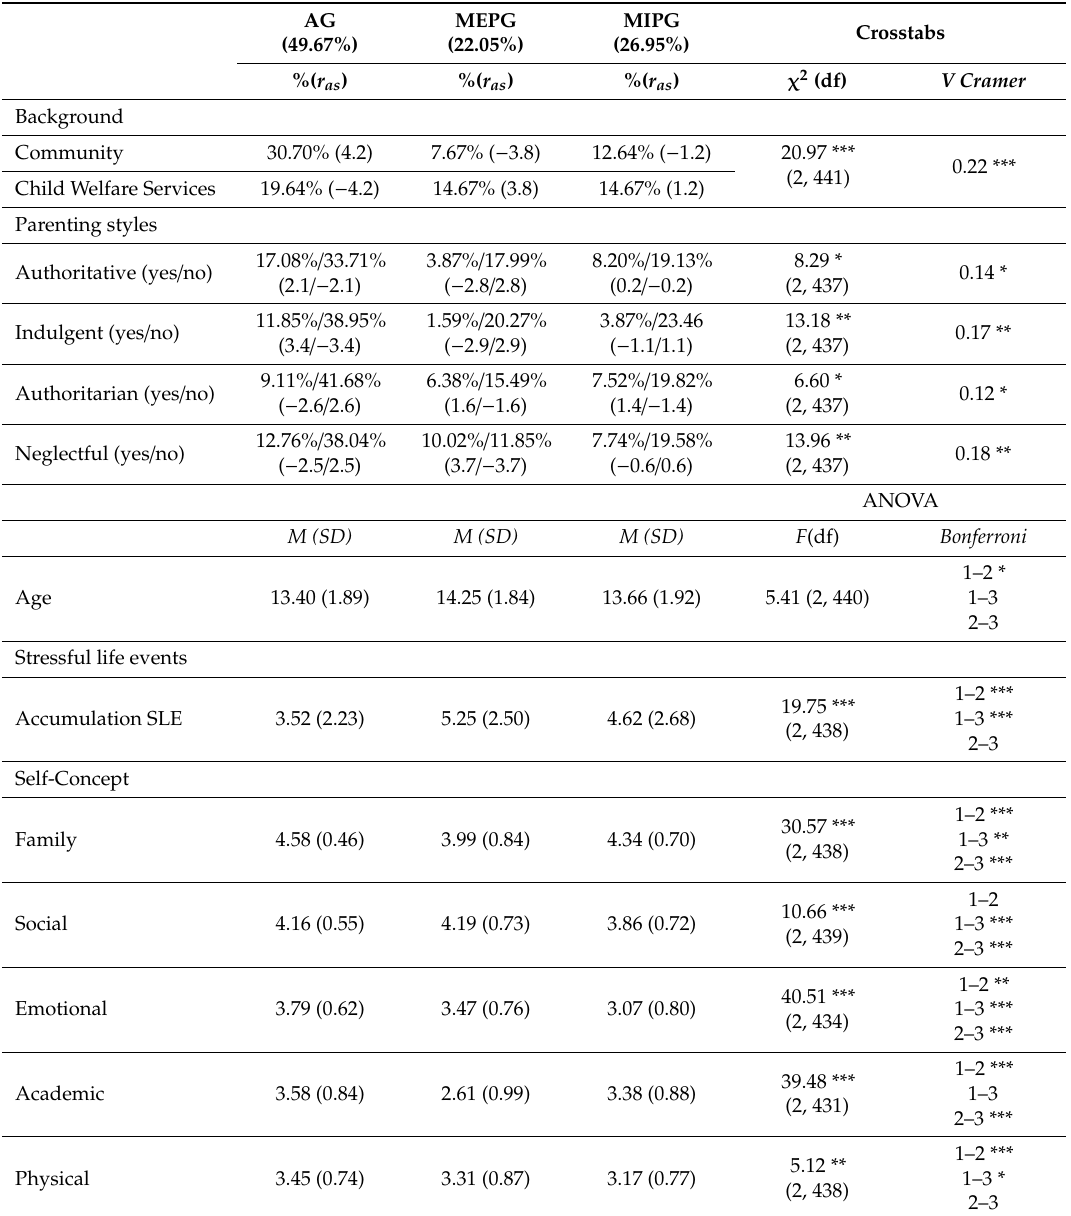
Table 3. Descriptive and bivariate analyses including the three resulting clusters and di ff erent individual, family, and social